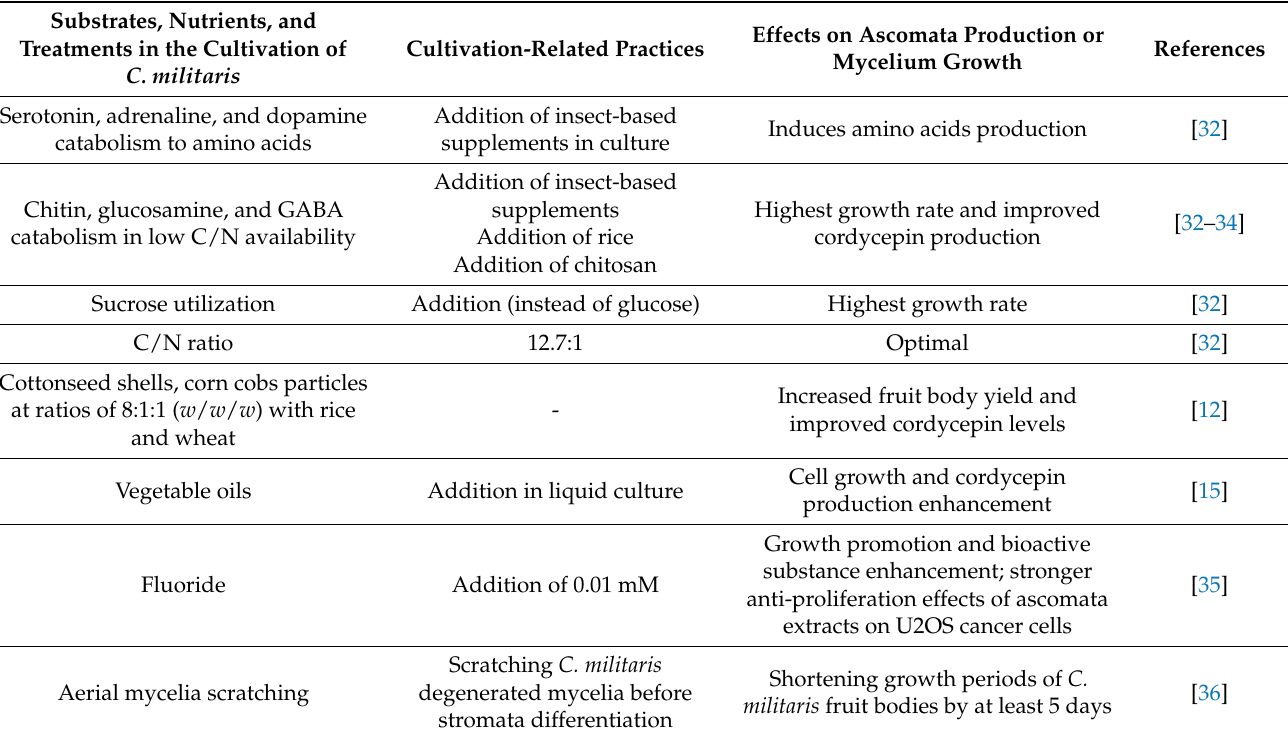
Table 2. Basic requirements and cultivation practices affecting ascomata production or mycelium growth in C. militaris . Substrates, Nutrients,